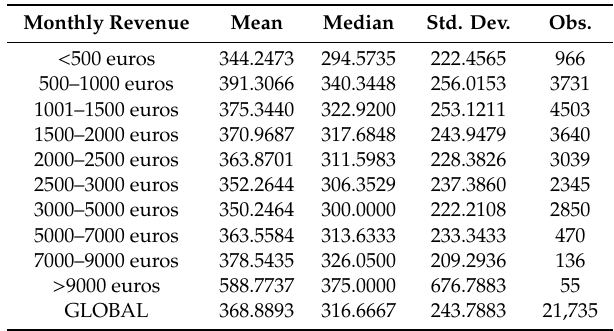
Table 1. Per capita yearly electricity expenditure. By monthly revenue level. Monthly Revenue Mean Median Std. Dev.